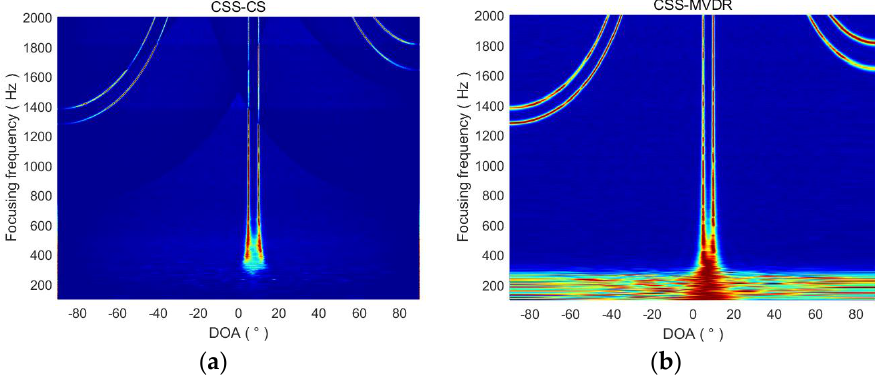
Figure 2. DOA estimation results of CSS-CS and CSS-MVDR in terms of focused frequencies (targets at 5° and 10°). ( a ) DOA estimation results of CSS-CS; ( b ) DOA estimation results of CSS-MVDR.